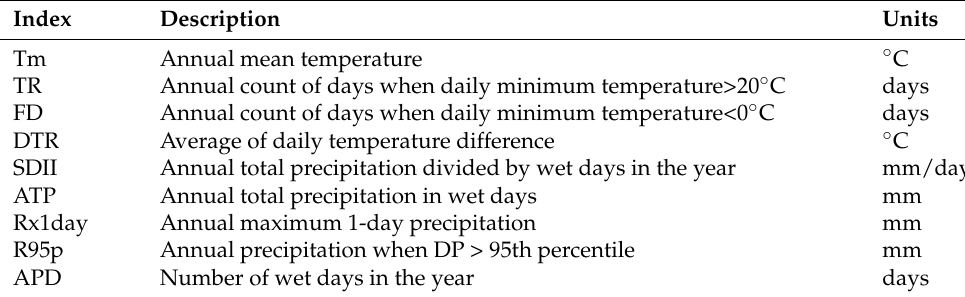
Table 2. Definitions of the precipitation and temperature